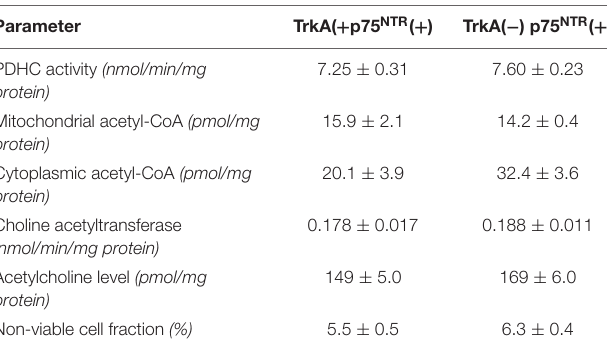
TABLE 3 | Basal parameters of acetyl-CoA and ACh metabolism in TrkA( − ) and TrkA( + ) cholinergic SN56 neuronal cells.